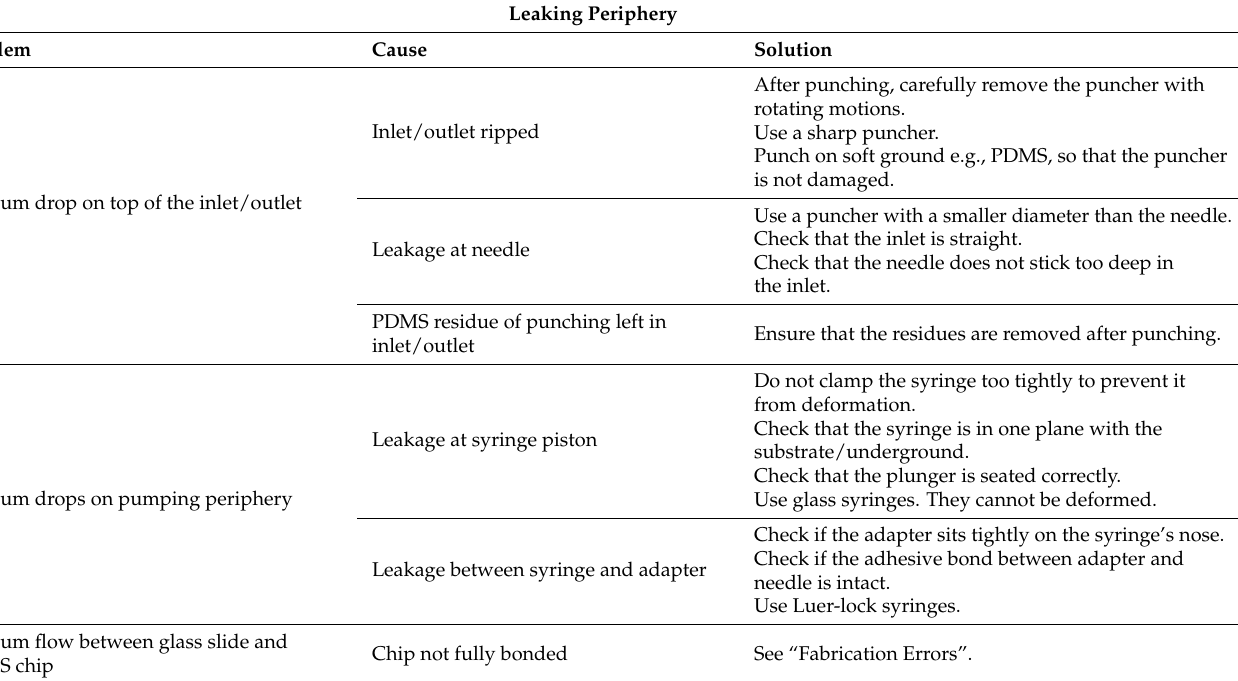
Table 4. Listed are the most frequently occurring challenges concerning leaking periphery with their respective cause and a suggested